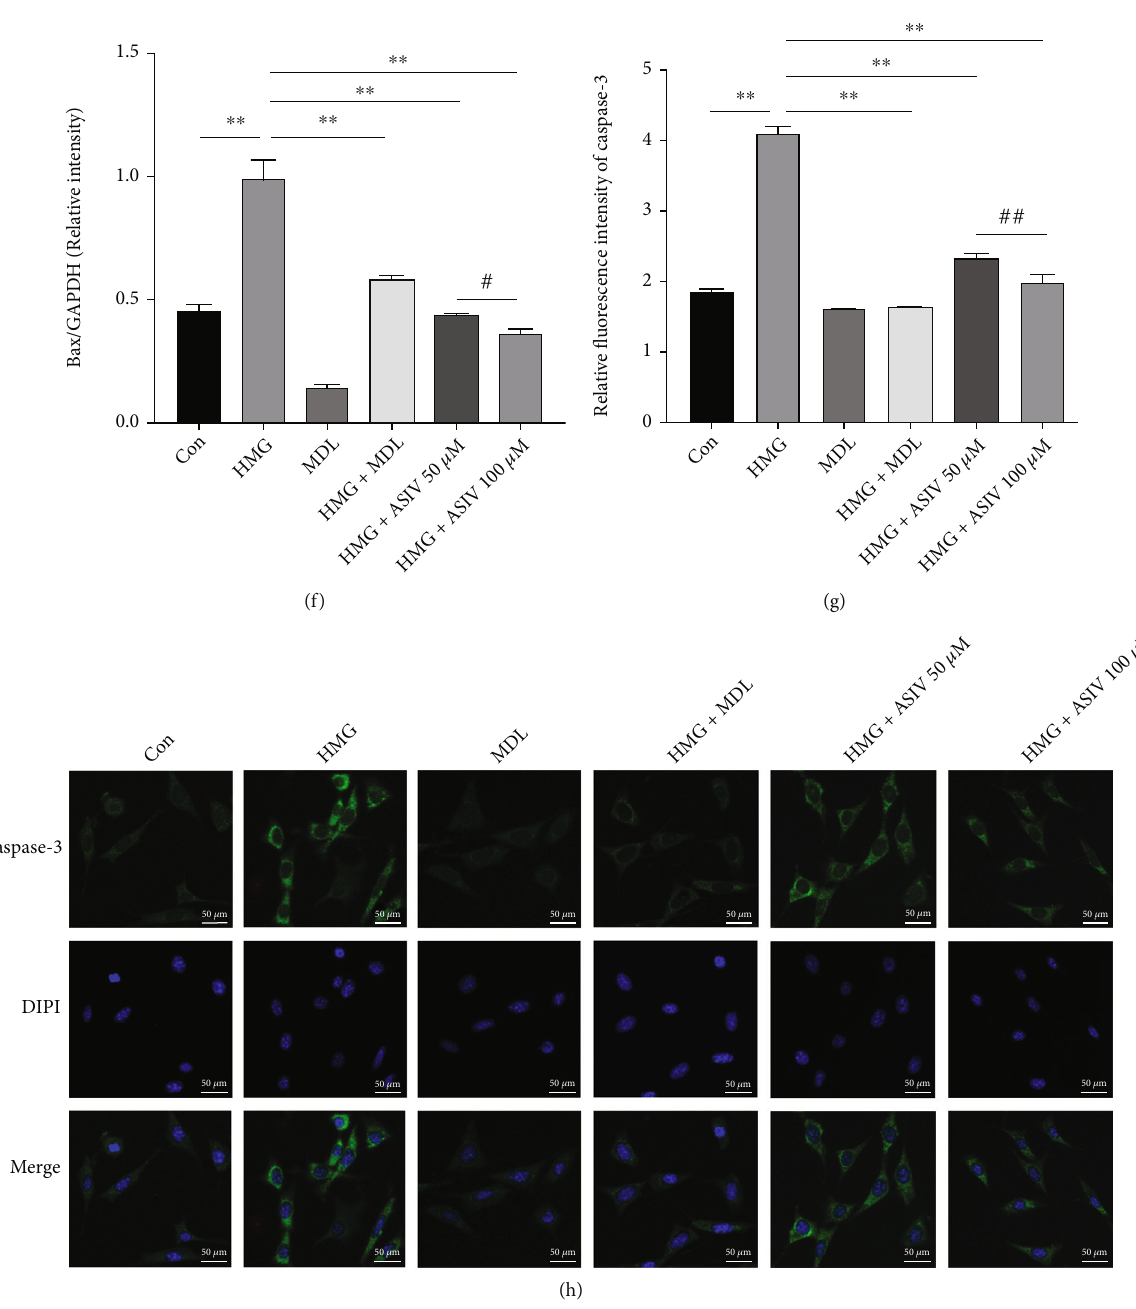
Figure 7: AS-IV inhibits apoptosis of hypoxic HT22 cells. (a, b) The apoptosis rate of HT22 cells was detected by fl ow cytometry ( n = 3 ; = 343 : 883 ). (c – f) Caspase-3, Bax, and Bcl-2 protein expression levels were observed by Western blotting ( n = 3 ; Caspase-3, F F ð 5,12 Þ = 75 : 979 ; Bax, F = 170 : 087 ; Bcl-2, F = 77 : 832 ). (g, h) The fl uorescence expression of caspase-3 protein was observed by ð 5,12 Þ ð 5,12 Þ immuno fl uorescence ( n = 3 ; F ð 5,12 Þ = 713 : 355 ). Data are presented as the mean ± SD . ∗∗ P < 0 : 01 compared with the HMG group, # P < 0 : 05 , ## P < 0 : 01 compared with the ASIV 50 μ M